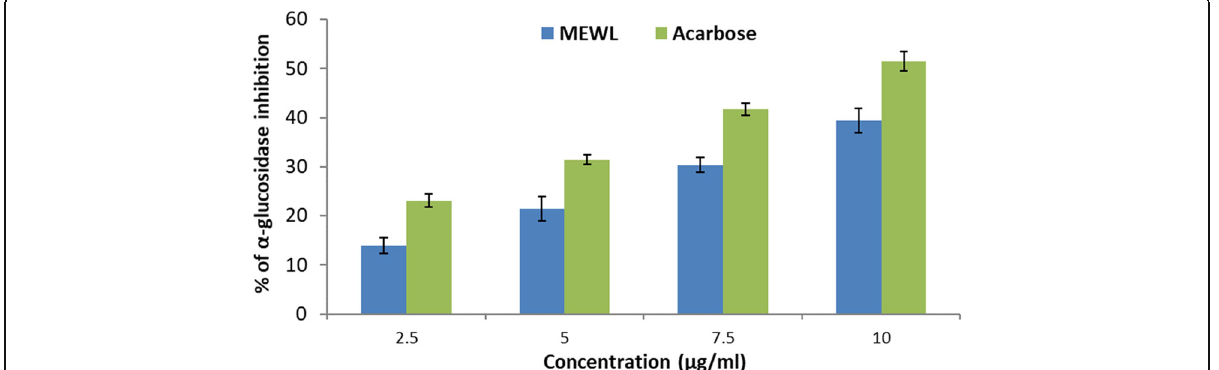
Fig. 2 α -glucosidase inhibition activity of methanolic extract of W. chinensis leaf (MEWL). All data are expressed as mean ± SD (n; number of separate experiments = 3)